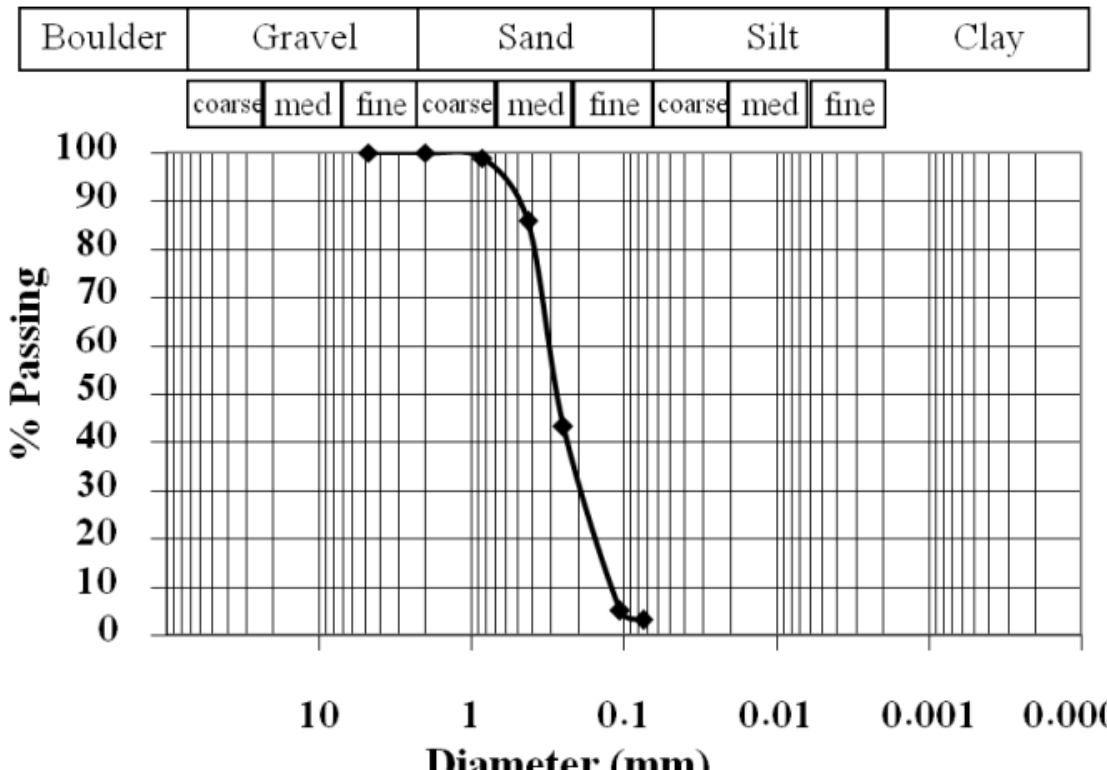
Figure 9. The sieve analysis of specimen 3 at 66.8E km at El-ferdan